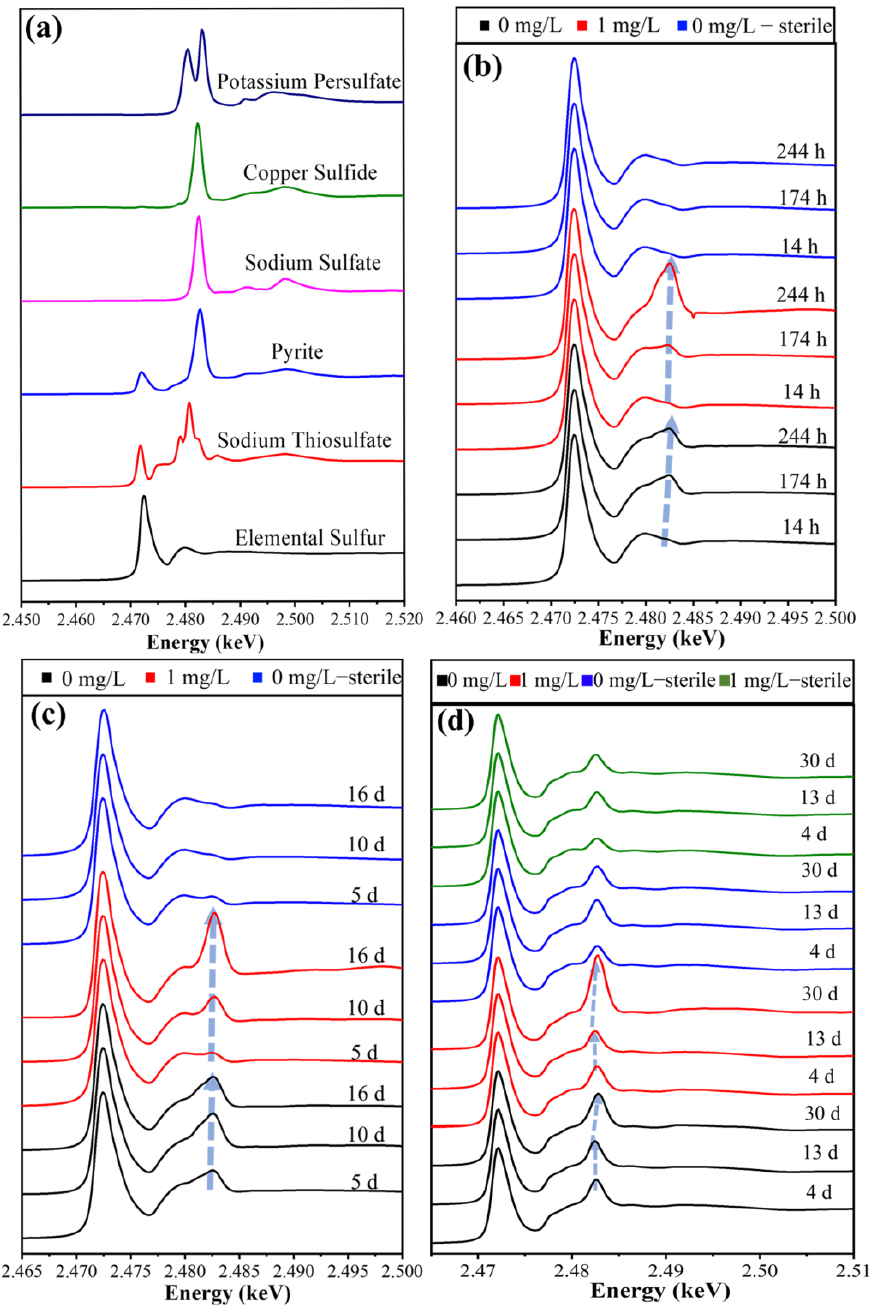
Figure 8. XANES images of bacterial cells of A. ferrooxidans ATCC 23270 in the presence of Hg 2+ . ( a ) reference samples; ( b ) S 0 oxidation; ( c ) anaerobic Fe 3+ reduction coupled with S 0 oxidation; ( d ) aerobic–anaerobic